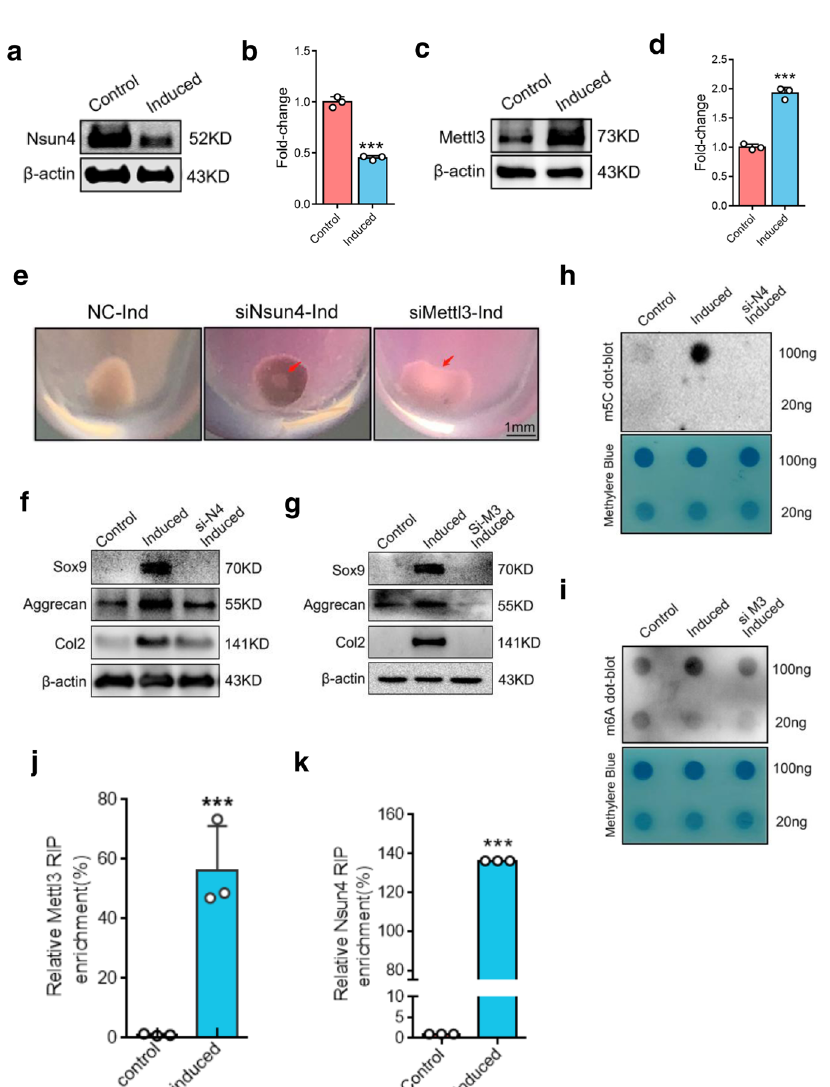
Fig. 2 Nsun4 and Mettl3 are both required on chondrogenic differentiation. a , b Nsun4 protein ( a ) and mRNA ( b ) expression during BMSCs chondrogenic differentiation tested by western blot and RT-qPCR. β -actin is used as a loading control. c , d Western blot ( c ) and RT-qPCR ( d ) showing expression of Mettl3 in control and chondrogenic induction. e Chondroblast formation of the Negative Control and Nsun4/Mettl3 knockdown BMSCs on chondrogenic differentiation. f , g Protein expressions of Sox9, Aggrecan, Col2 were measured by western blot in BMSCs transfected with siRNA of Nsun4 ( f ) and Mettl3 ( g ) on chondrogenic differentiation. h , i Dot blot analysis of m 5 C ( h ) and m 6 A ( i ) in total mRNA of the BMSCs transfected with or without siRNAs of Nsun4 or Mettl3 for 24 h and then further induced for 7 days. j , k Mettl3 ( j ) and Nsun4 ( k ) RIP-qPCR analysis of Sox9 mRNA in control or induced cells on chondrogenic differentiation. Data are presented as means ± SD from three independent experiment. *** p < 0.001, by Student ’ s t